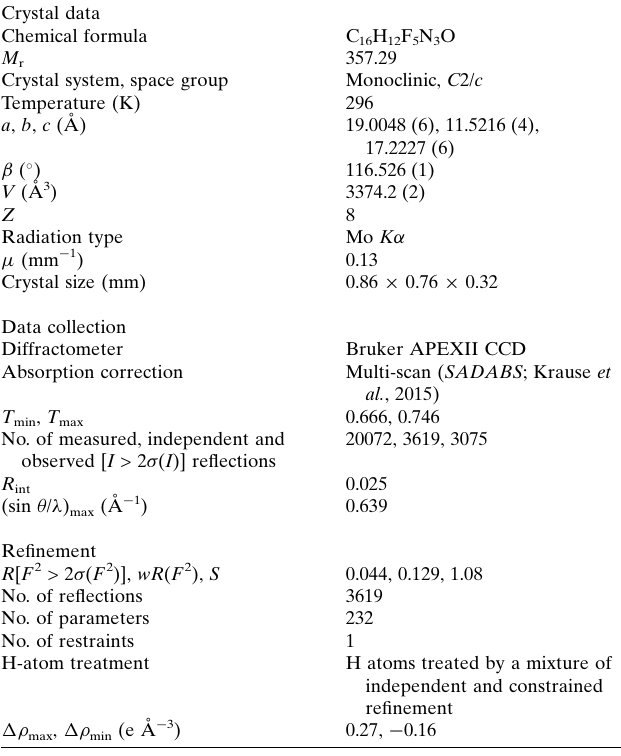
Crystal data Chemical